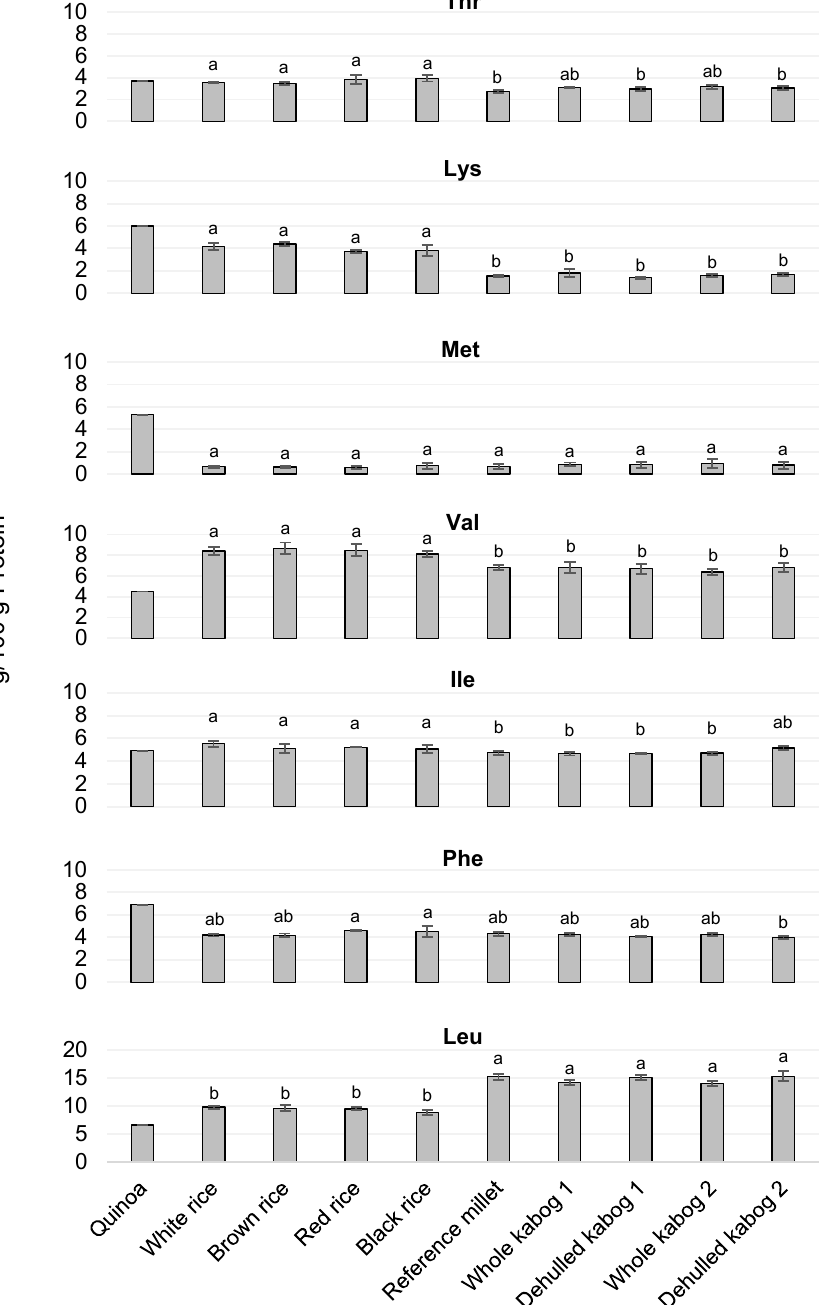
Figure 2. Essential amino acid content (g / 100 g protein) of rice (white, brown, red, and black), reference millet, and kabog millet (whole and dehulled) samples compared to quinoa [15]. Kabog millet 1 refers to kabog millet obtained from farmer source 1, and kabog millet 2 refers to kabog millet obtained from farmer source 2. The values followed by the same letters are not significantly di ff erent at p < 0.05 using one-way ANOVA Tukey’s